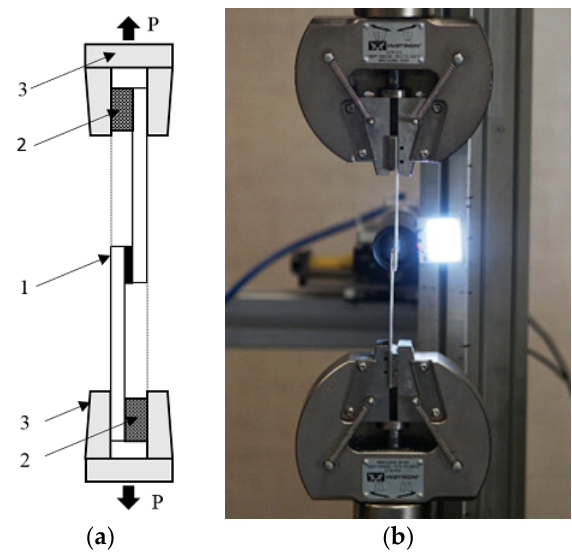
Figure 11. The way of the specimen montage in a holder of the strength testing machine: ( a ) scheme of montage: 1—specimen, 2—pad, 3—holder of the strength testing machine, ( b ) image of the test. Failure shear stresses are determined by their tension e ff ect on single-lap adhesive